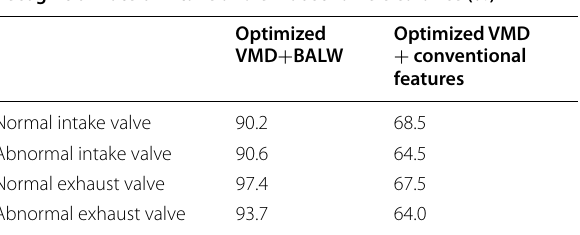
Table 5 Comparison of the results of the recognition rate of intake and exhaust valve